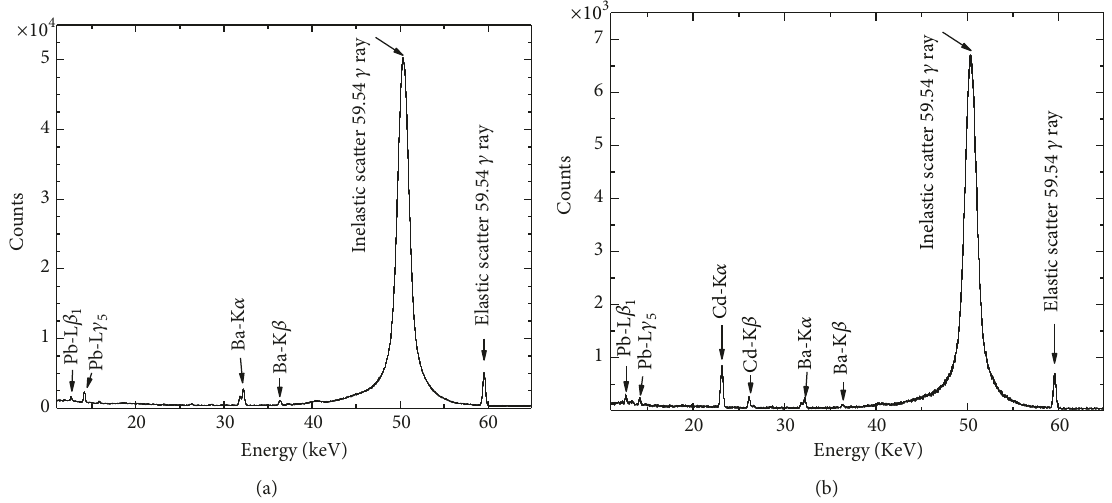
Figure 5: Typical X-ray spectra of C. vulgaris (a) before and (b) after treatment with 10% textile effluent.